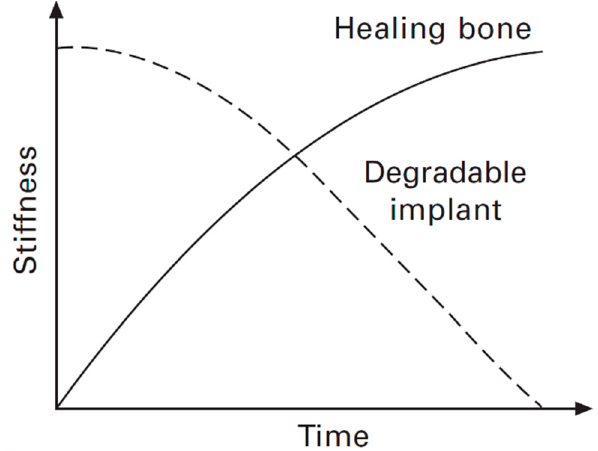
Figure 3. A Stiffness–Time inverse relationship between degradable implants and healing bone. Reproduced with permission from Witte, F., et al., Magnesium (Mg) corrosion: a challenging concept for degradable implants; published by Woodhead Publishing, 2011 [60].